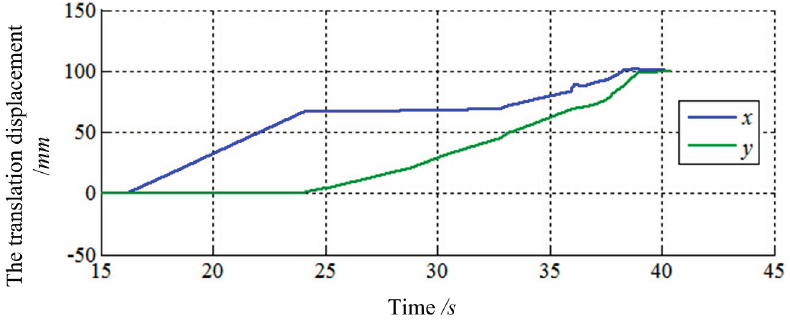
Figure 24. The translation displacement of load sensing ring based on Equation (13).